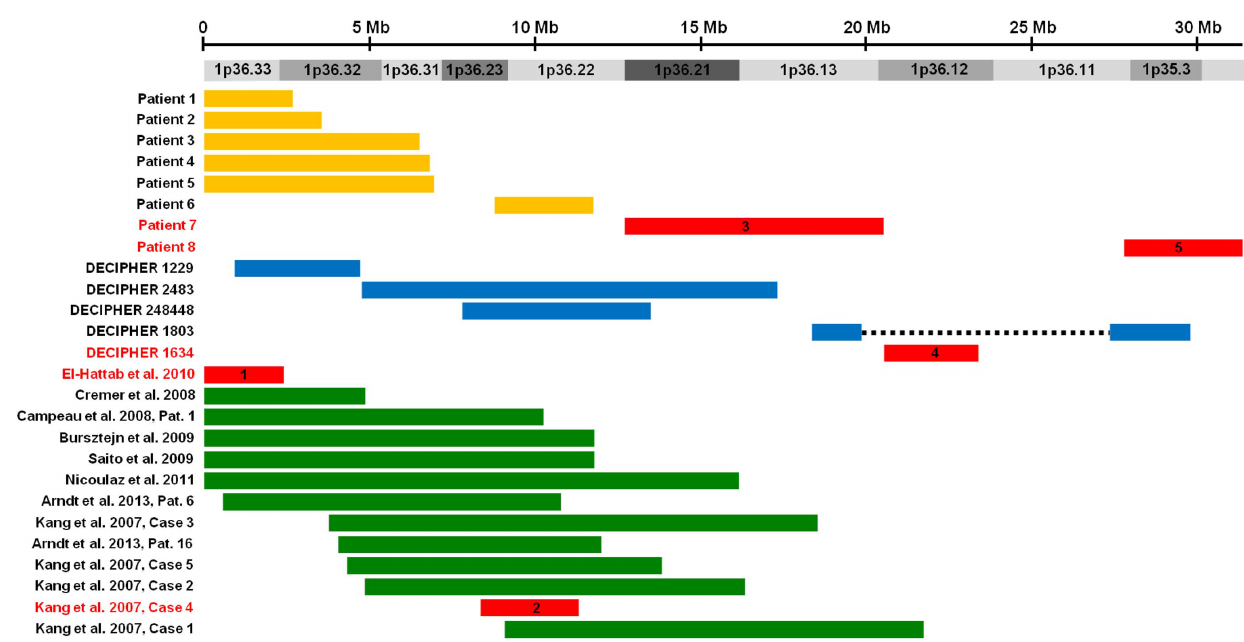
Figure 1. Delineation of five critical regions for cardiovascular malformations on 1p36. Solid bars represent isolated 1p36 deletions identified in individuals with cardiovascular malformations. These deletions are grouped based on the source from which data was obtained: 1) patients referred to the Medical Genetics Laboratories at Baylor College of Medicine for copy number analysis and 2) patients recruited into a research study on 1p36 deletions at Baylor College of Medicine [orange], 3) the DECIPHER database [blue], and 4) a review of the literature [green]. Deletions that define non-overlapping critical region for cardiovascular malformation are shown in red and are numbered sequentially from the telomere.